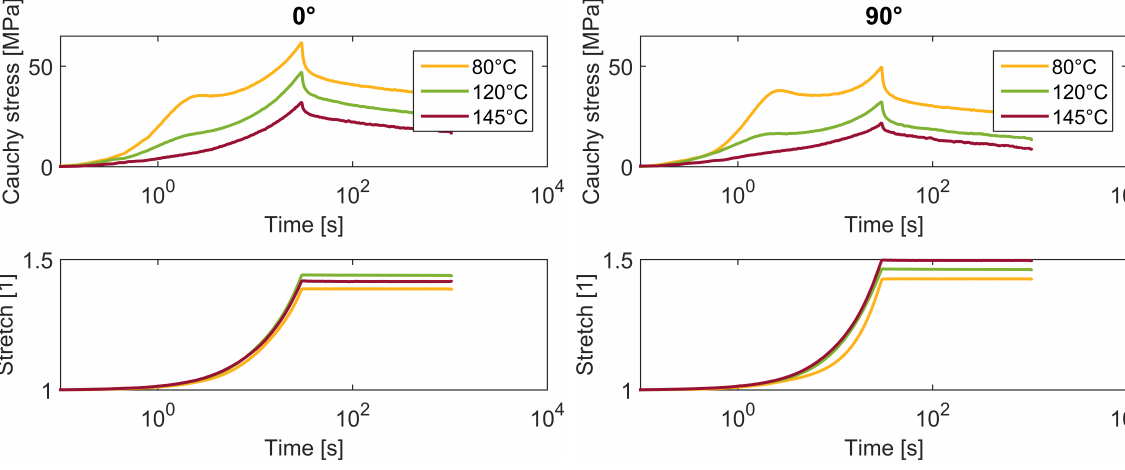
Figure 6. Relation between the Cauchy stress and time depends on temperature for 0°and